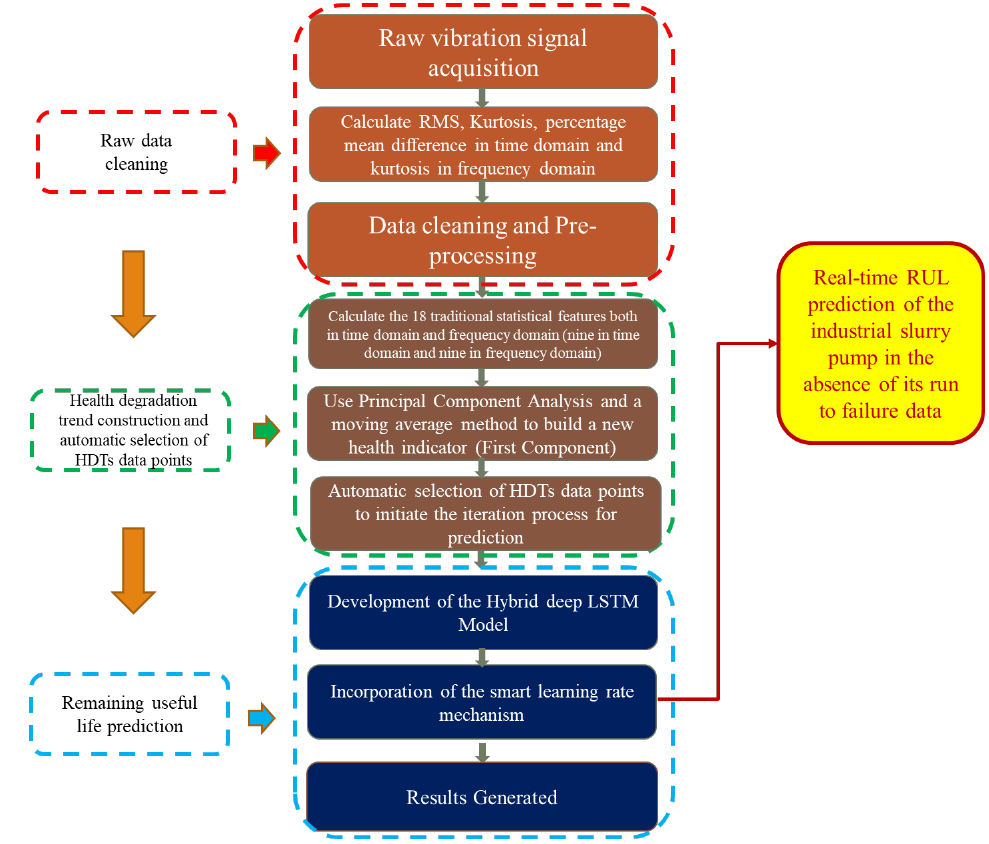
Figure 1. The proposed framework for data filtering, health degradation assessment, automatic selection of HDTs data points, and online RUL prediction of slurry pump.